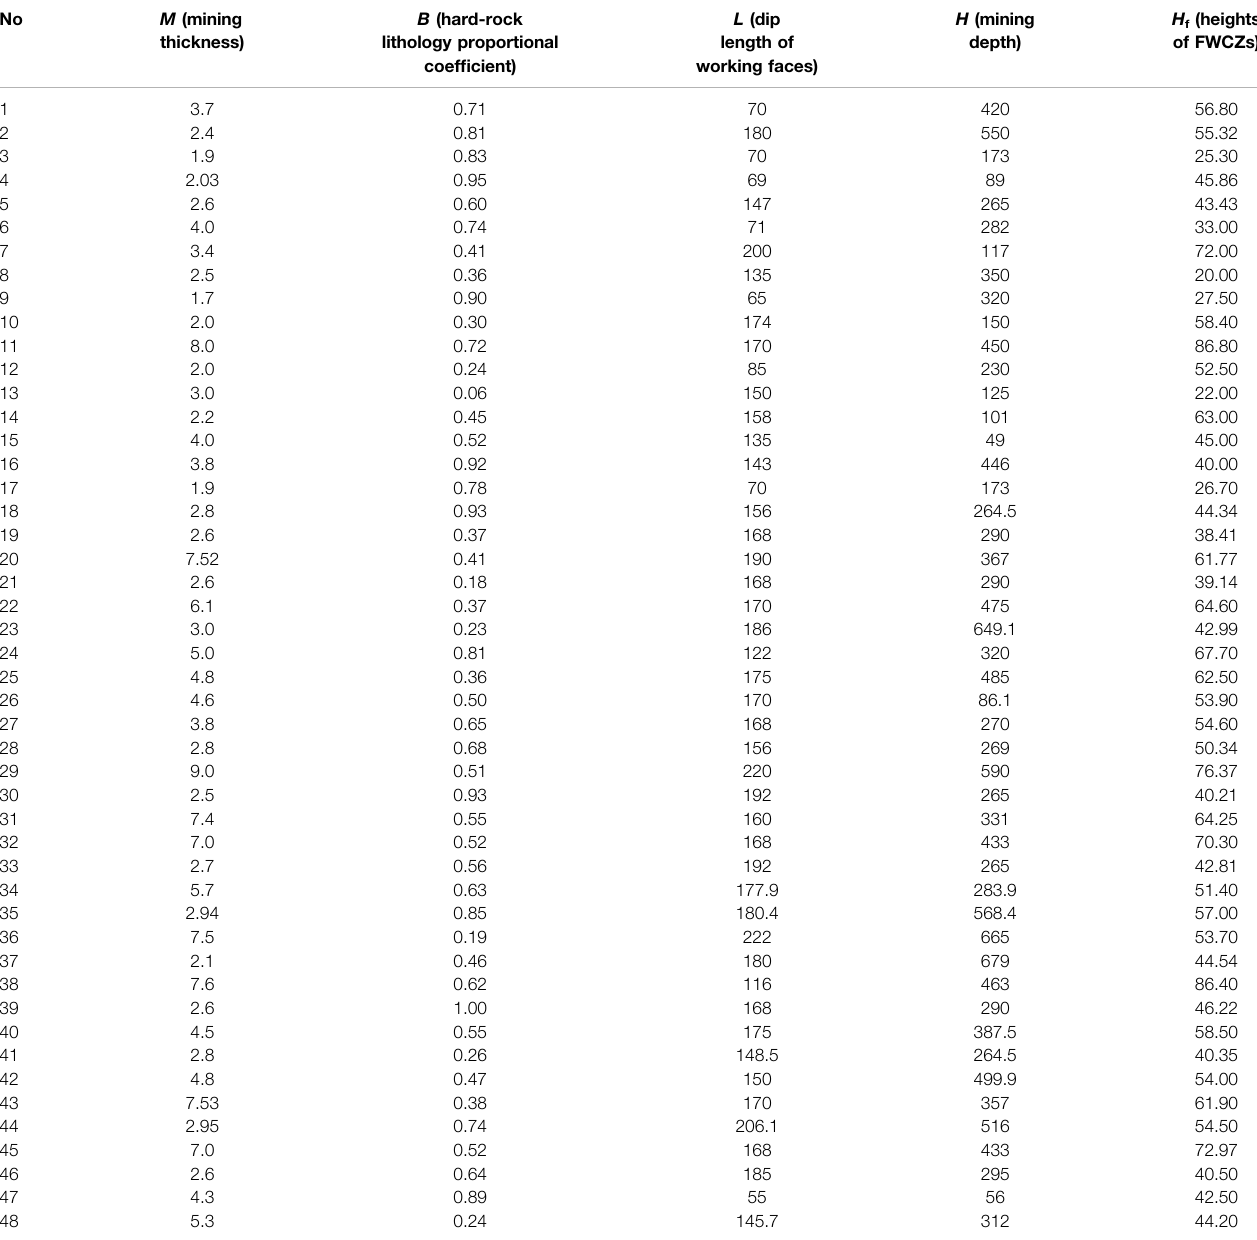
TABLE 1 | Sample data: factors in fl uencing the height of an FWCZ. No M (mining thickness)